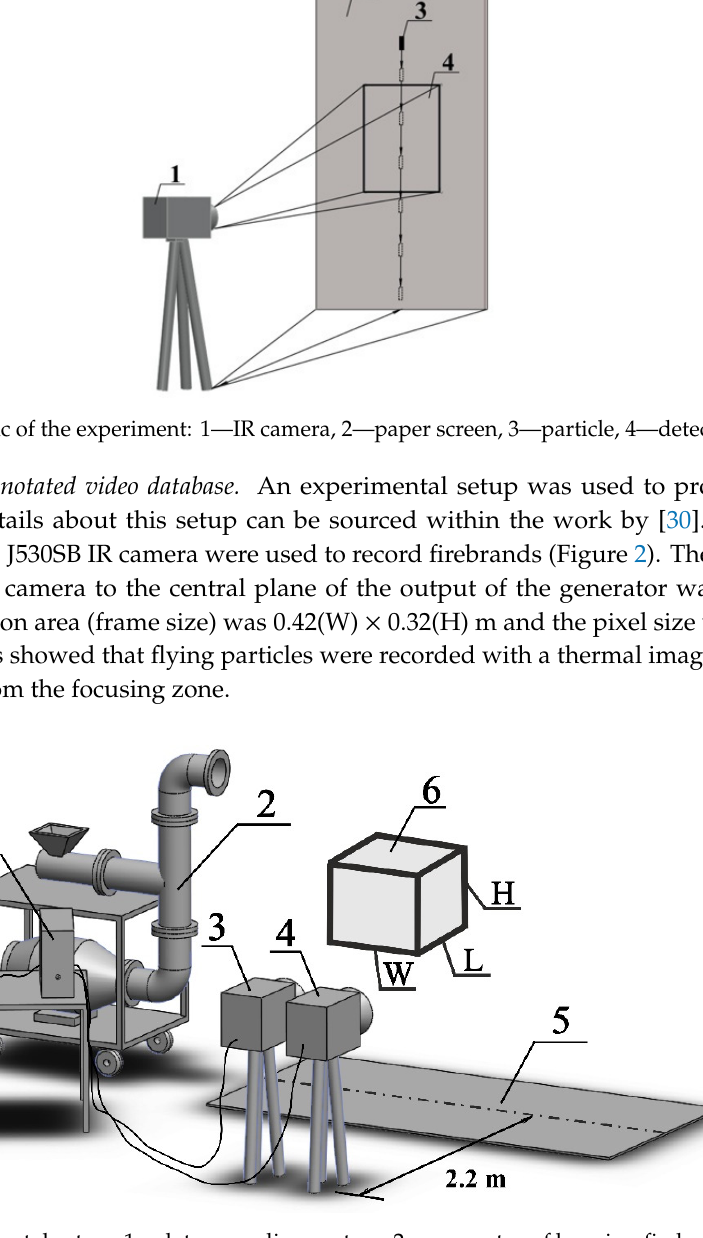
Figure 1. Schematic of the experiment: 1—IR camera, 2—paper screen, 3—particle, 4—detection frame.